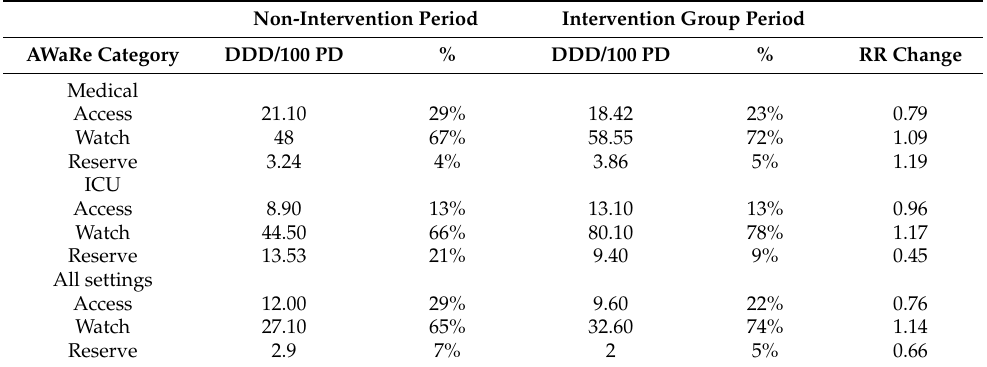
Table 3. Percentage of total antibacterial consumption expressed as DDD/PD categorised by WHO AWaRe category for the non-intervention and ASP MDT intervention